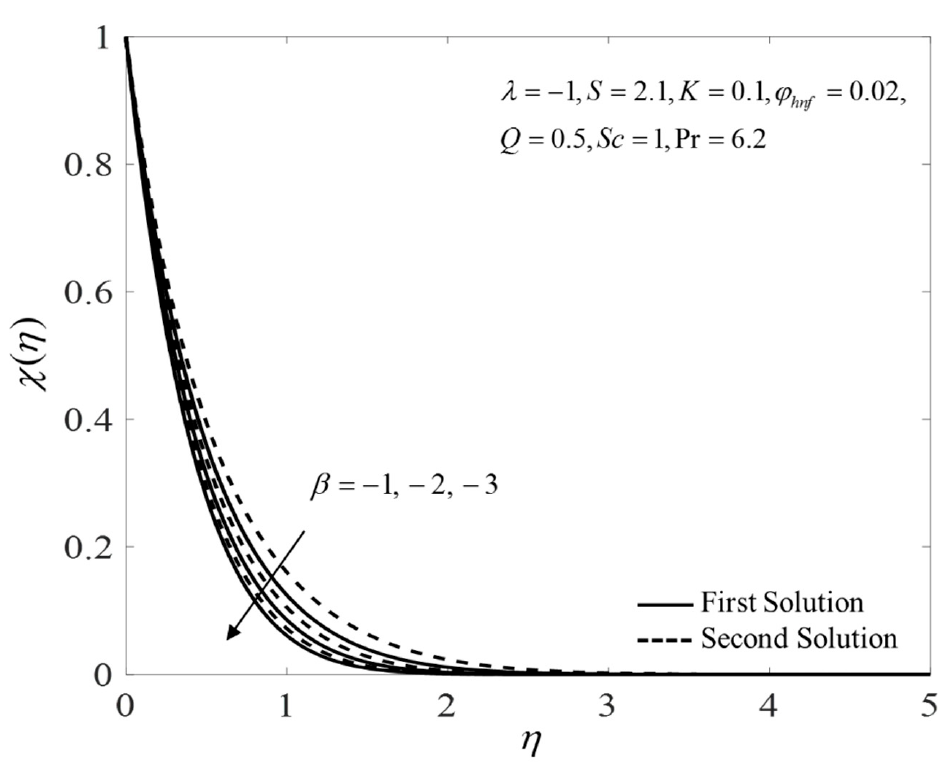
Figure 6. Plot of ( )  for several values of  . Figure 6. Plot of θ ( η ) for several values of β .